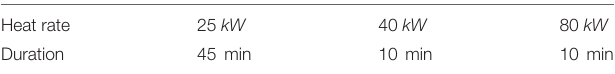
FIGURE 3 | Shaft-soil model. Aggregates are embedded in the concrete